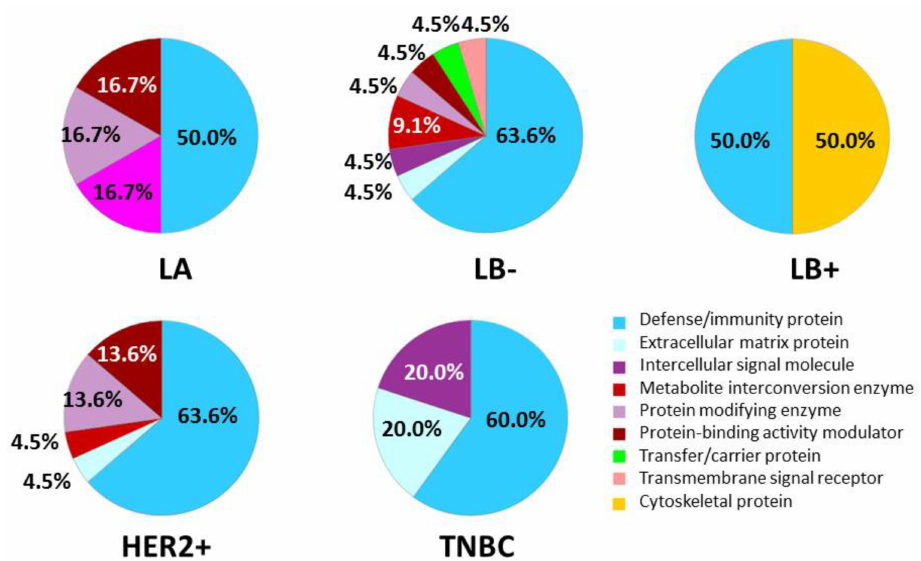
Figure 5. Classification according to the protein class of the di ff erentially regulated proteins specific to each of the five subtypes of BC found in the ex vivo formed coronas analyzed with the PANTHER